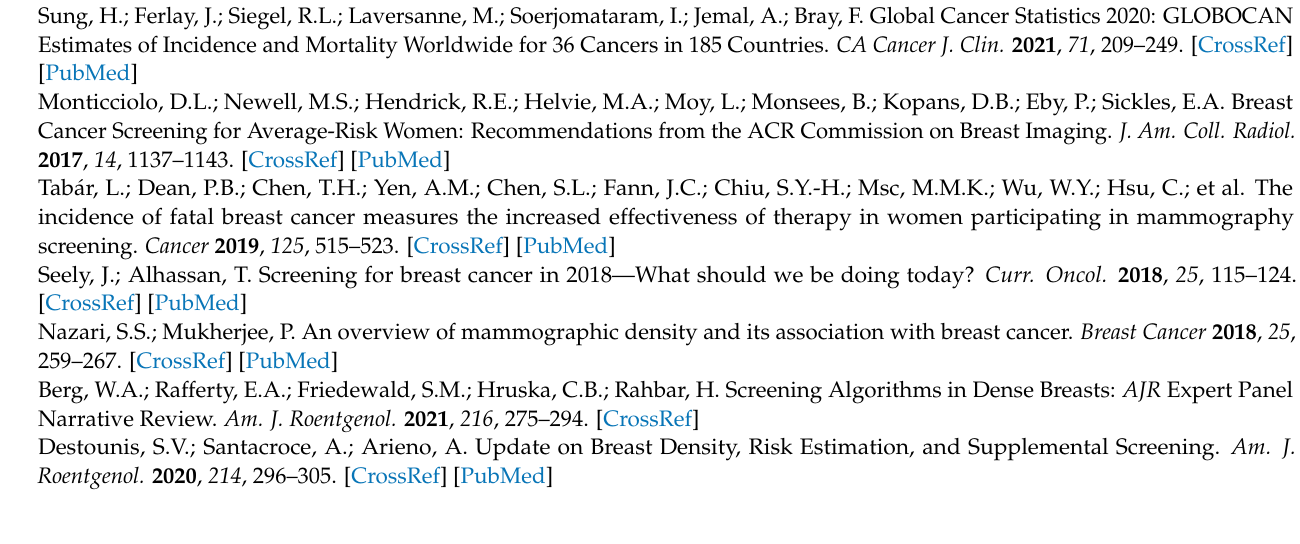
995 subjects; Table S2: Image parameters in training, validation and test datasets; Table S3: Model accuracy on their respective validation dataset for all screening years for 4 BI-RADS categories; Table S4: Model accuracy on their respective validation dataset for all screening years for 2 categories (Non-dense and